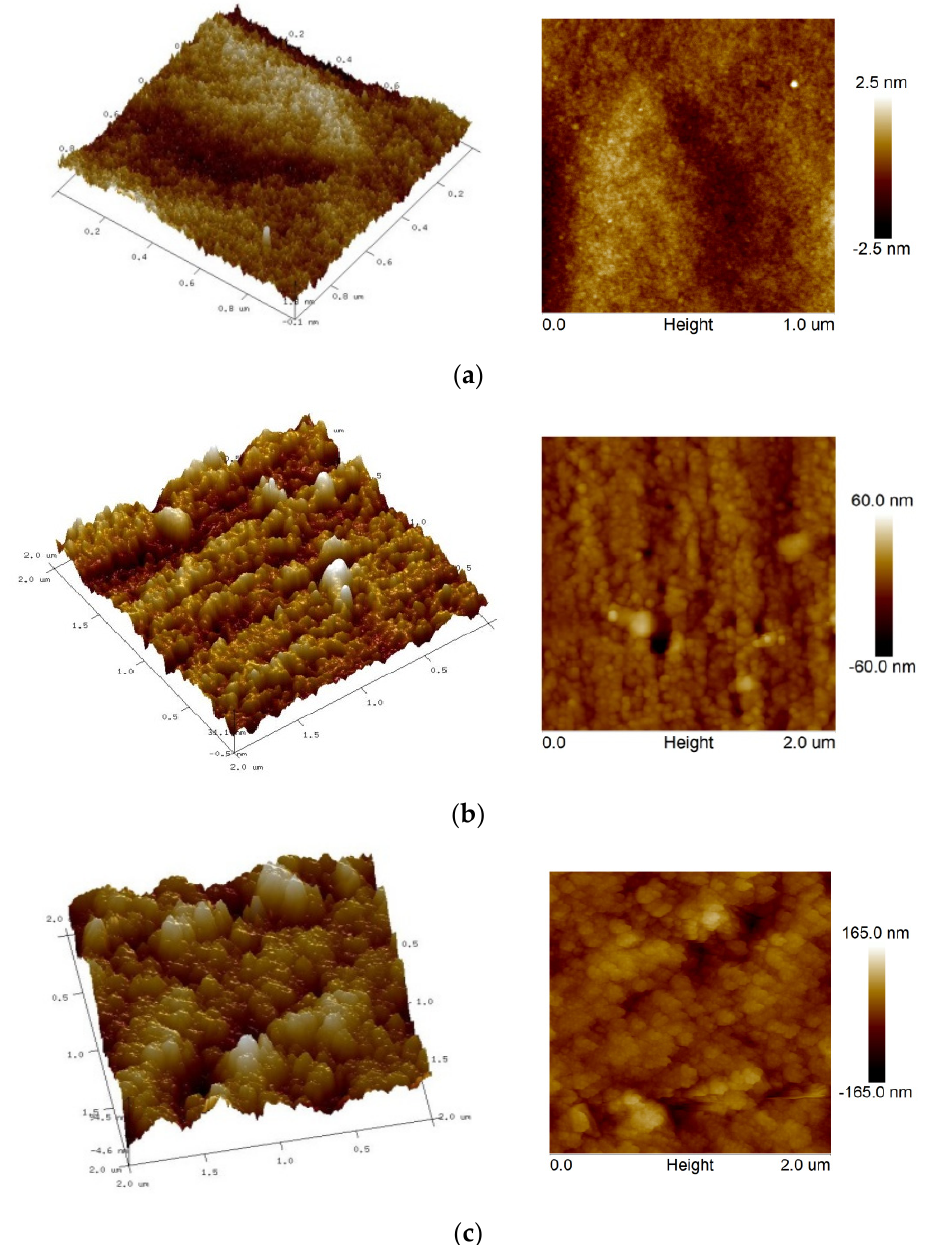
Figure 11. AFM 2D and 3D images of: ( a ) the thin film deposited from 5% SiO 2 sol (synthesized with TEOS) on steel; ( b ) the thin film deposited from TEOS/DDS containing sol on steel; ( c ) the thin film deposited from Aerosil TM solution on steel.